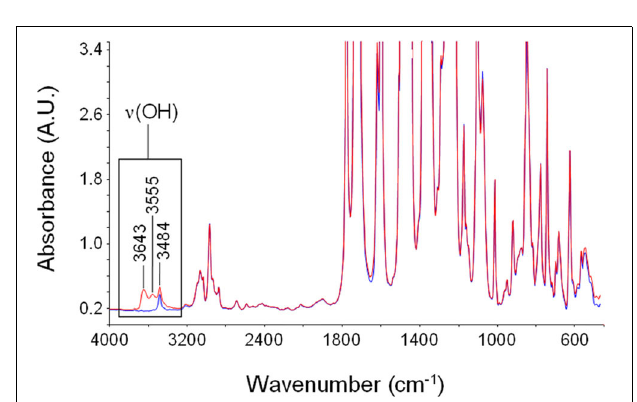
FIGURE 6 | Difference spectra (wet-dry) representative of water absorbed in PEEK at 30 ◦ C after equilibration with water vapor at several values of p / p 0 .